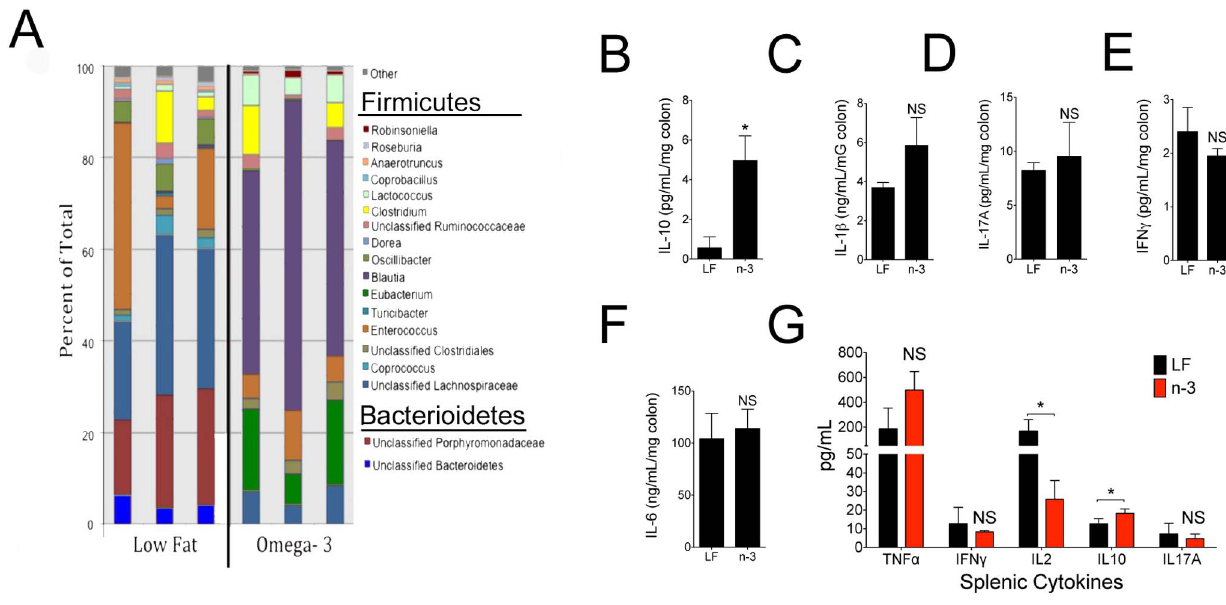
Figure 2. High omega-3 intake altered colonic inflammation and gut microbiome. (a) 16S ribosomal RNA genes in cecal stool samples of female mice. Each bar represents one mouse. Phyla (Bacterioidetes, Firmicutes, or other) are classified into genus or unclassified family members. Further breakdown of composition within each phylum can be found in Table 2. (b-f) Cytokine production from female excised colons stimulated with LPS for 24–72 hours (n=4–6). (g) Cytokine production from male splenocytes stimulated with LPS for 24–72 hours (n=4–6). Results are representative of 2–3 independent experiments in BALB/c mice and displayed as mean + s.e.m. Significance determined by t test. All experiments were repeated with similar results in both genders. Gender is indicated when representative experiments are shown; otherwise, data reflects both male and female mice with matched ratios within experiments. n designates number of mice per experiment. The results from the Low Fat group shown in (a) are a subset of what was previously reported in reference 13. The remaining data is